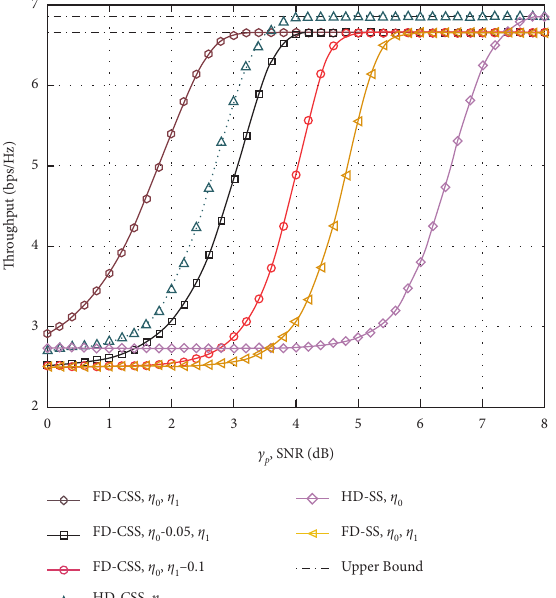
Figure 5: FD-CSS throughput versus relative transmission